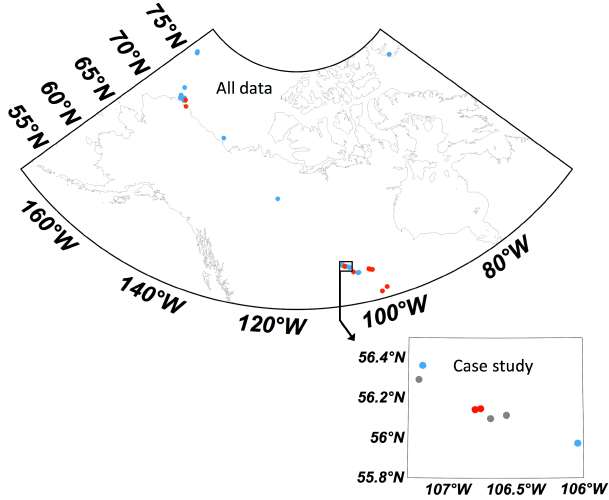
Figure 4. Map of cloud sample locations from all campaigns. Red points indicate biomass burning samples, blue cases indicate back- ground samples, and gray points indicate intermediate